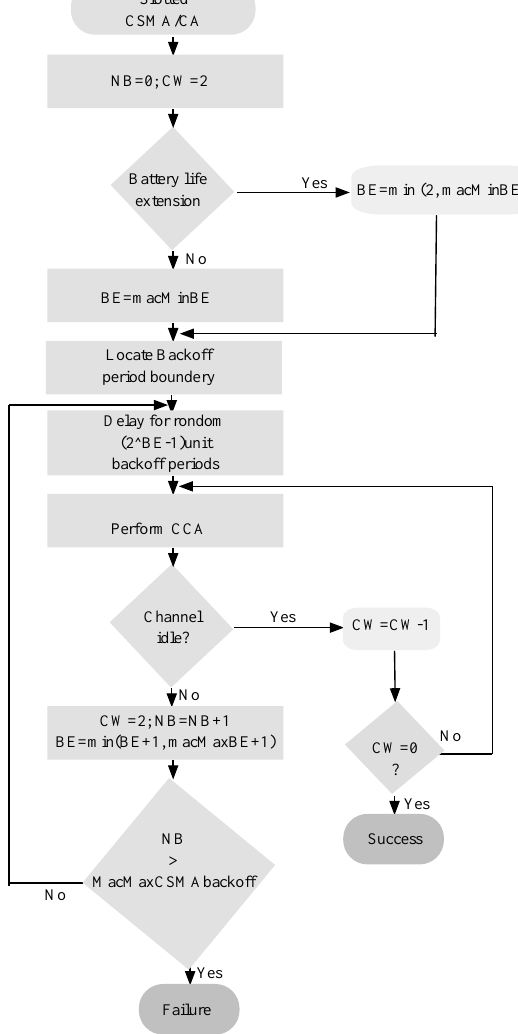
Figure 3. Flowchart of slotted CSMA/CA algorithm for IEEE 802.15.4.